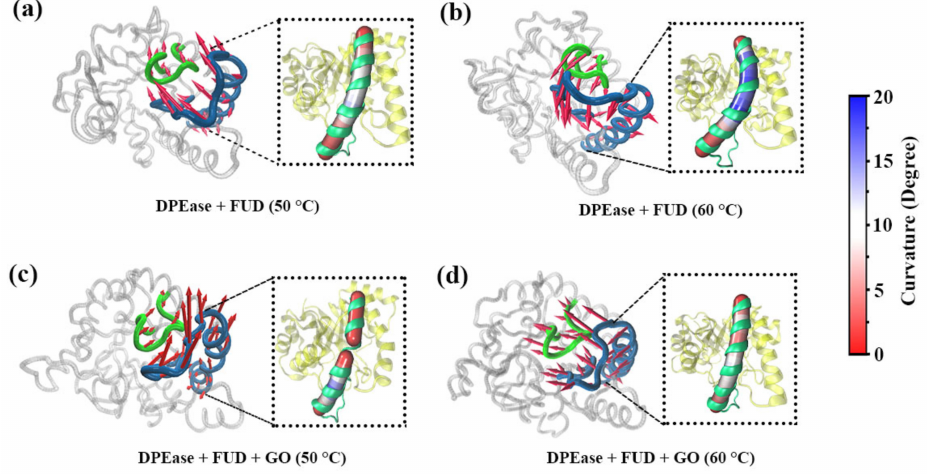
Figure 9. Collective motions along the first eigenvector obtained from principal component analysis for four systems: ( a ) DPEase + FUD (50 ◦ C); ( b ) DPEase + FUD (60 ◦ C); ( c ) DPEase + FUD + GO (50 ◦ C); ( d ) DPEase + FUD + GO (60 ◦ C). Loop β 4- α 4 is shown in green tube, while loop β 5- α 5 and α 5 are displayed in skybule tube. Red arrows represented movement trends. α 5 residues were colored mapped from blue (most curved) through white and to red (least curved) according to their calculated